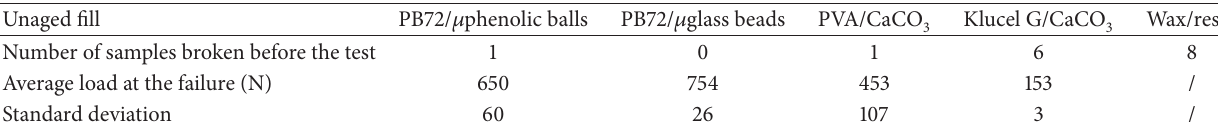
Table 2: Shearing load at break.